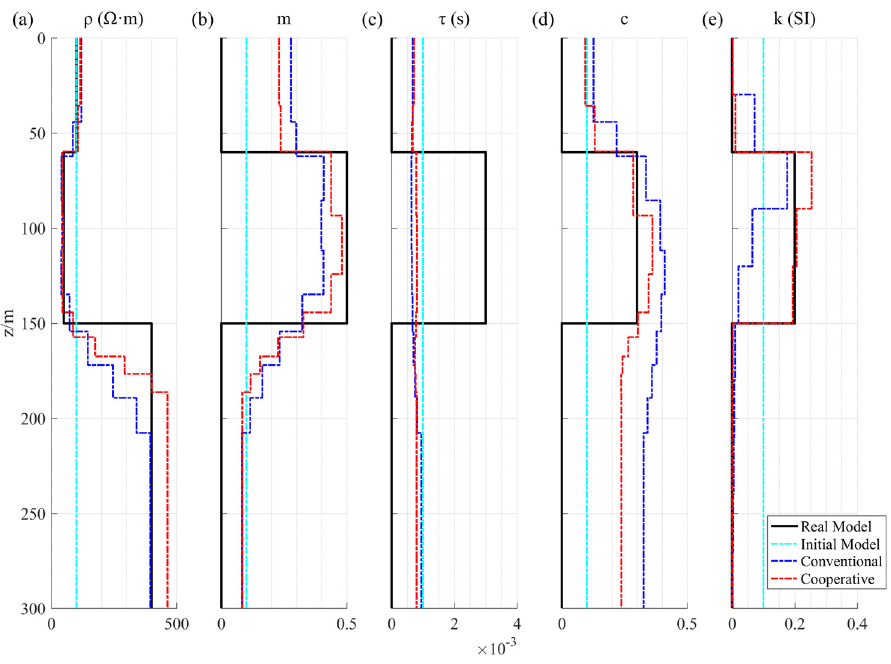
Figure 11. Results of the petrophysical parameters inversion at 200 m: ( a ) resistivity; ( b ) chargeability; ( c ) time constant; ( d ) frequency dependence; ( e ) permeability.